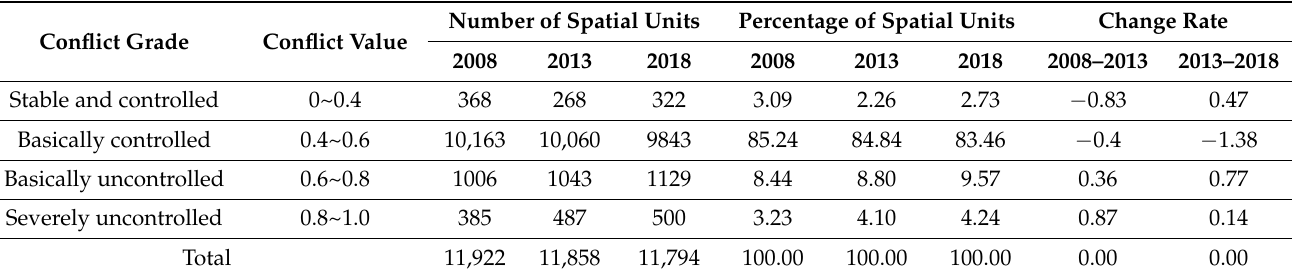
Table 2. Changes in the degree of land-use conflict between agricultural and ecological spaces in Lin’an District, 2008–2018. Number of Spatial Units Percentage of Spatial Units Change Rate Conflict Grade Conflict Value